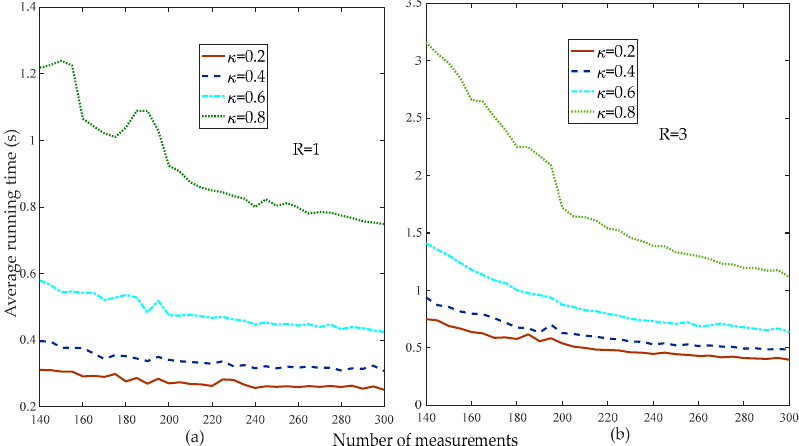
Figure 10. Reconstruction percentage of the proposed method with different weak selection